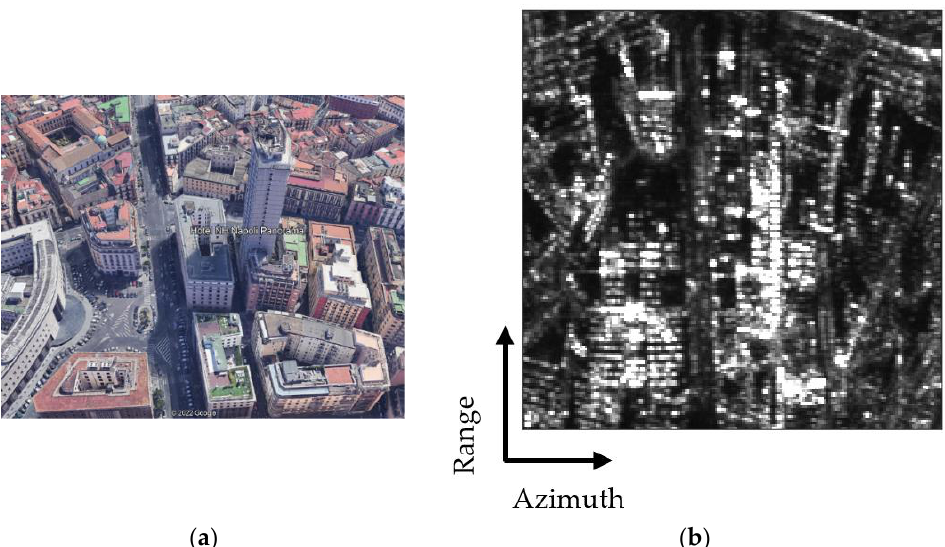
Figure 7. Images of Jolly Hotel, Naples, Italy. ( a ) Optical image and ( b ) SAR image (Copyright DLR 2012 – 2014).